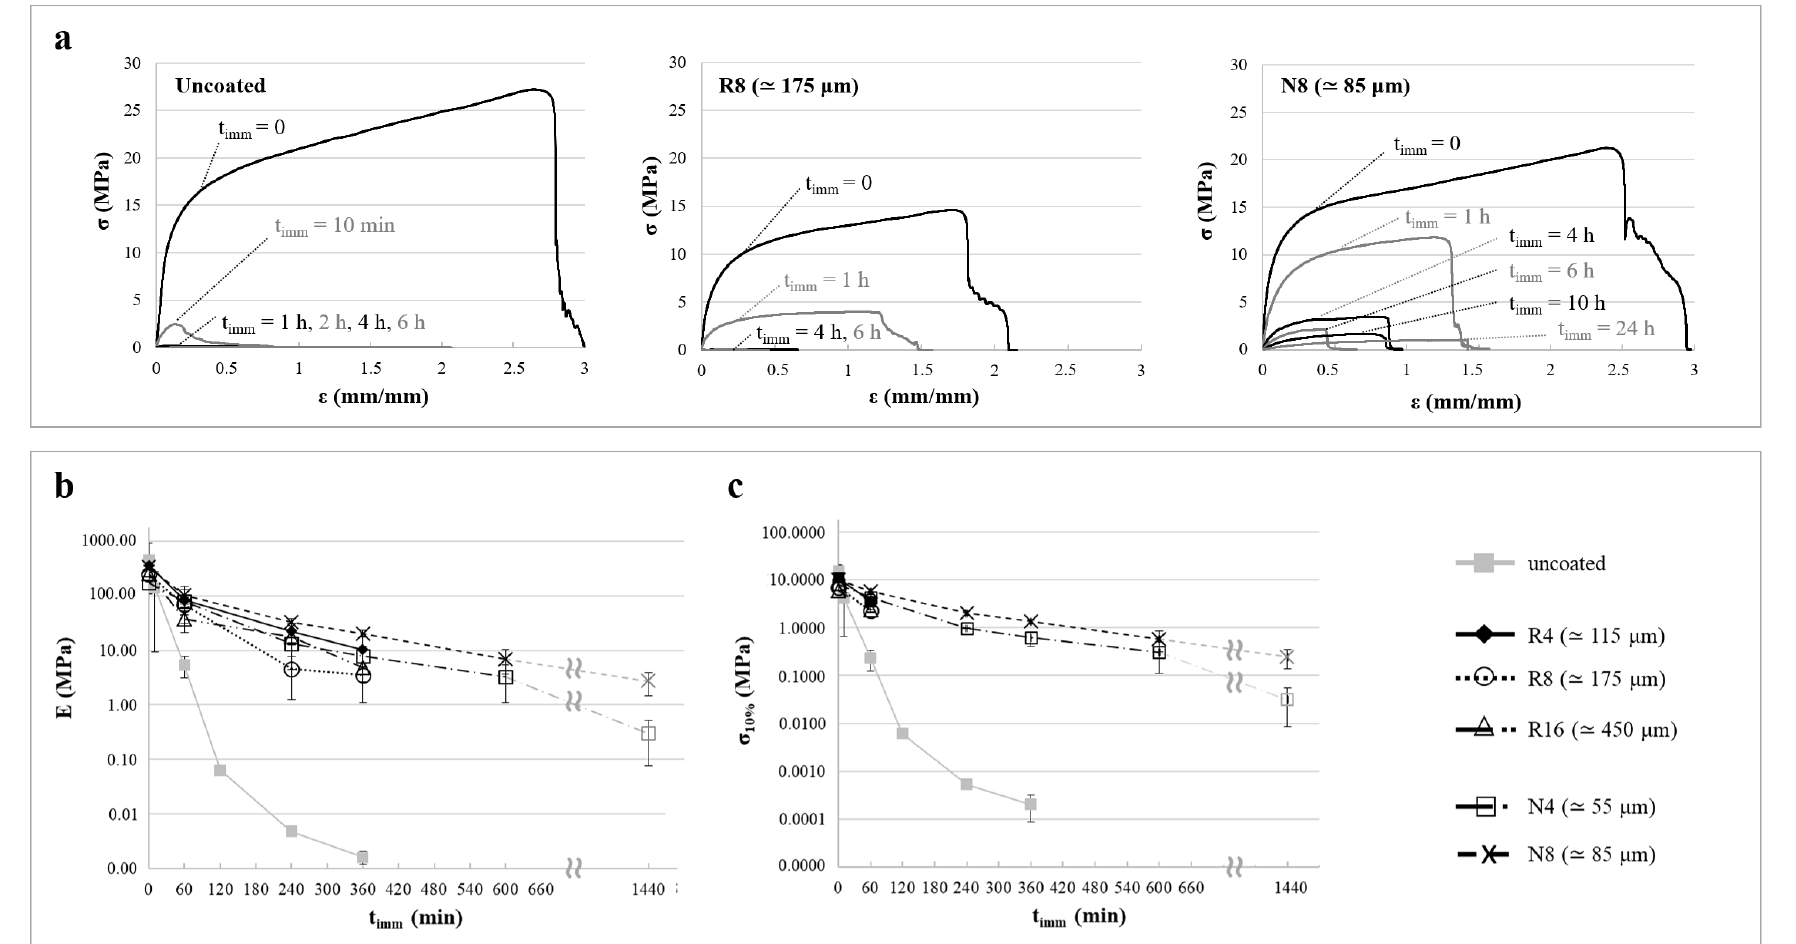
Figure 10. ( a ) Stress versus strain curves relevant to uncoated, R8, and N8 specimens tested under tensile conditions after different immersion times, and profiles of ( b ) E as well as of ( c ) σ 10% as a function of immersion time.